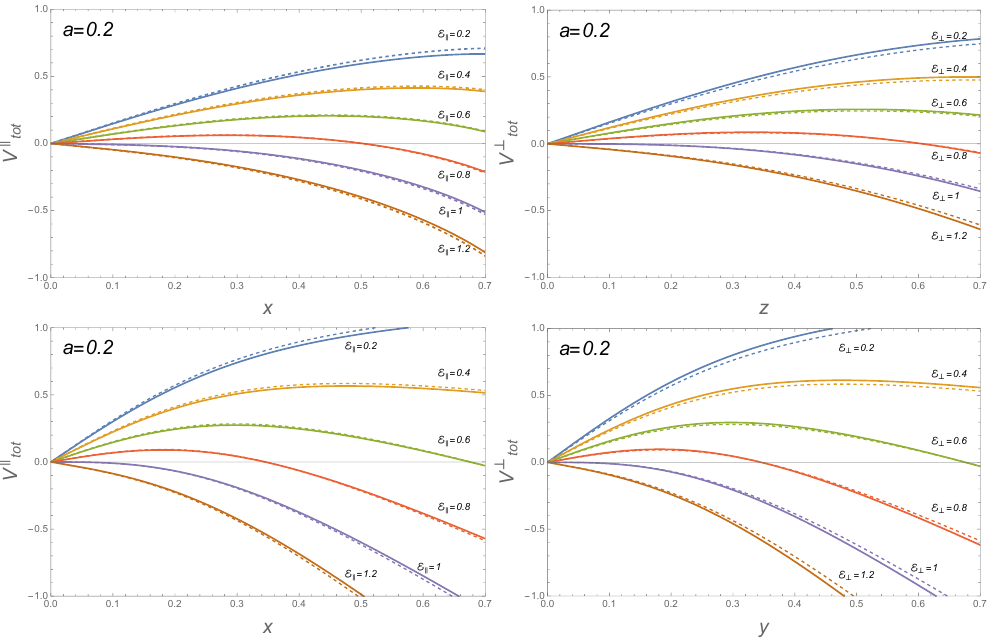
Figure 3 . The holographic potential V k , ⊥ with parallel “ k ” and perpendicular “ ⊥ ” electric field E k , ⊥ tot for a = 0 . 2 (solid lines). Upper: V k , ⊥ as a function of x, z in the black brane background. Lower: tot V k , ⊥ as a function of x, y in the bubble background. The dashed lines refer to the isotropic potential tot ( a = 0 ) with corresponding electric field in the black brane and bubble background respectively. The numerical calculation shows the barrier of the holographic potential V k , ⊥ is decreased/increased tot slightly by the anisotropy in parallel and perpendicular direction, both in the black brane and bubble